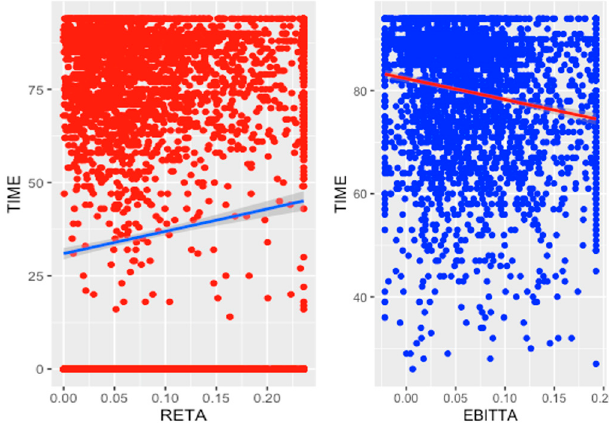
Figure 3. Influencing direction of RETA (retained earnings to total assets) and EBITTA (earnings before interest and tax to total assets) on time to publish annual reports (source: compiled from data processing by the authors).